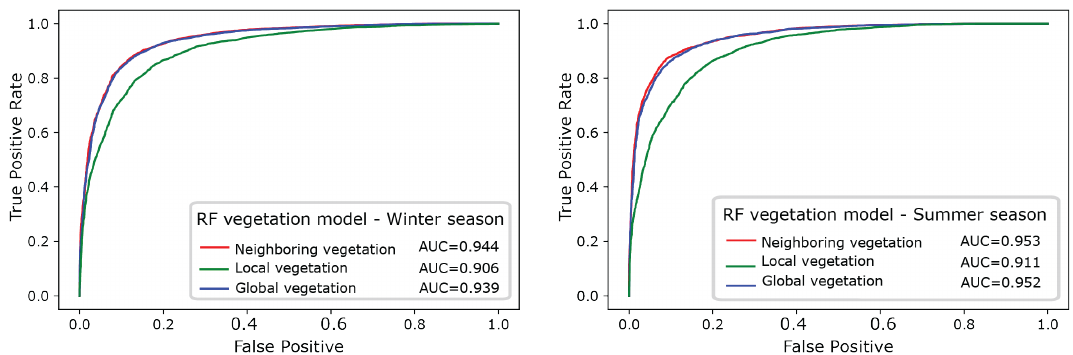
Figure 8. ROC curves for the three RF vegetation models and corresponding AUC values.